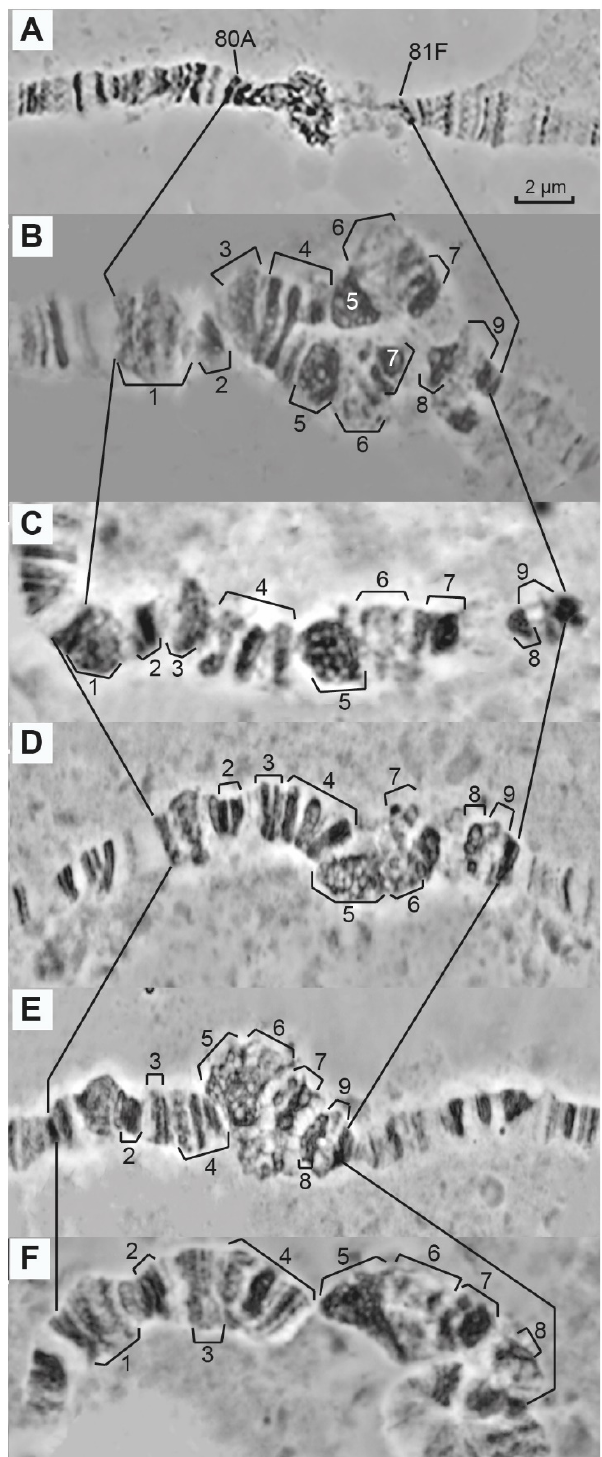
Figure 3. Diversity of the morphological forms of the newly polytenized heterochromatin in the control wild-type Drosophila melanogaster line, Oregon-R, ( A ) and in the triple-mutant Rif1 1 ; SuUR ES Su(var)3-9 06 larvae ( B – F ). Numbered brackets indicate regions of interest (aceto-orcein staining and phase contrast). Scale bar value is the same for every figure.